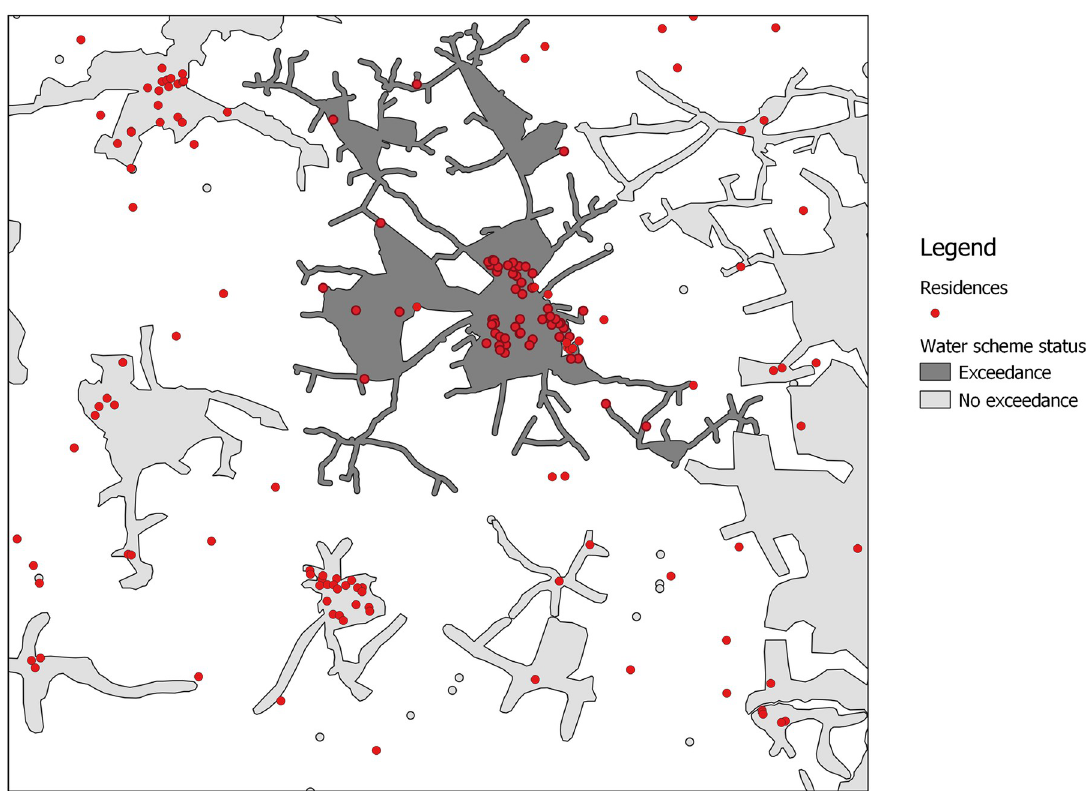
Fig 1. Hypothetical worked example of mapping of E . coli exceedance, water supply and residence.